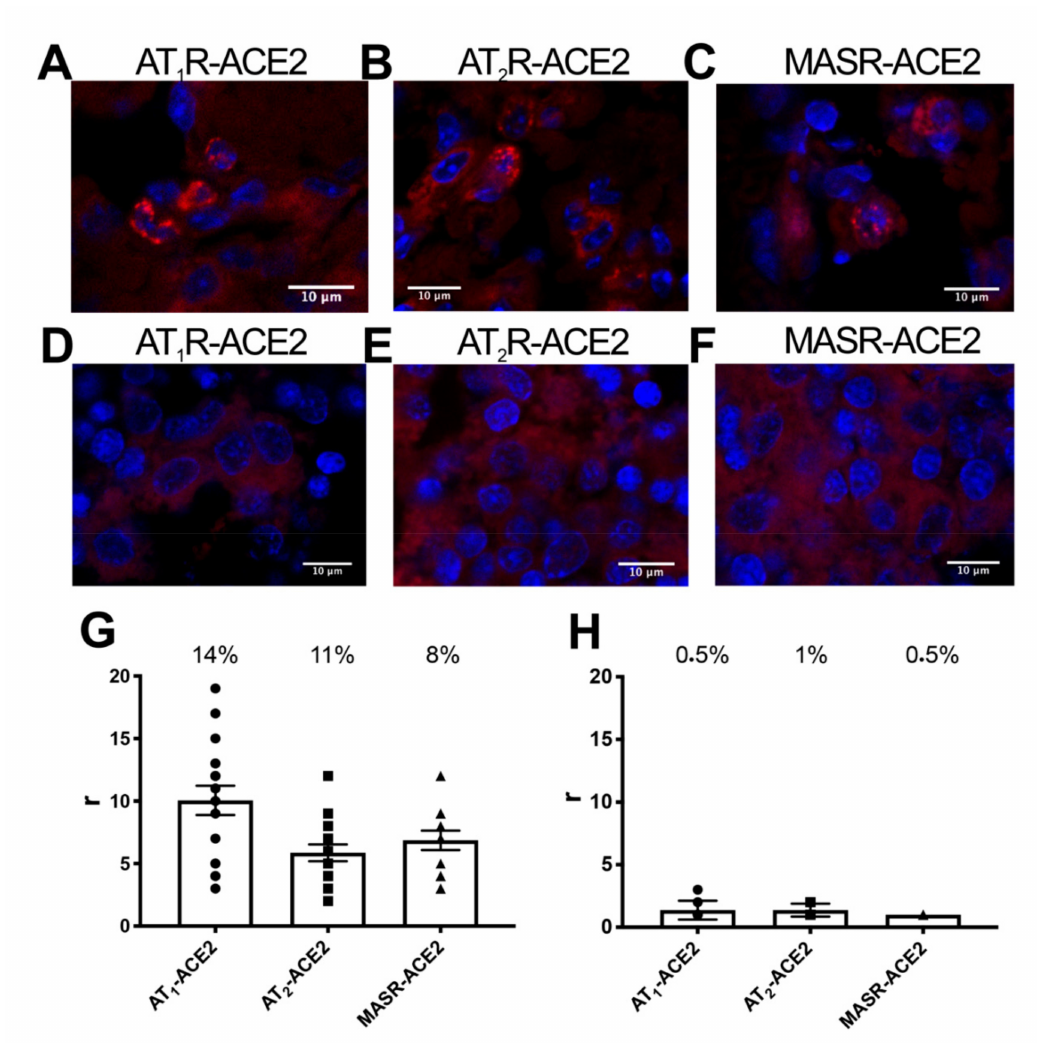
Figure 6. Detection of AT 1 R-ACE2, AT 2 R-ACE2, and MasR-ACE2 complexes in mouse lung tissue. Proximity Ligation Assays (PLAs) were performed using lung sections of adult ( A – C ) or 19-day fetal CD-1 mice ( D – F ) as described in the Methods. Cell nuclei were stained with Hoechst (blue). Protein complexes appear as red clusters or dots. Representative images corresponding to stacks of 4 sequential planes are shown. Graphs ( G , H ) display the number of clusters and spots in spot-containing cells. Values presented are the mean ± SEM of 5 independent